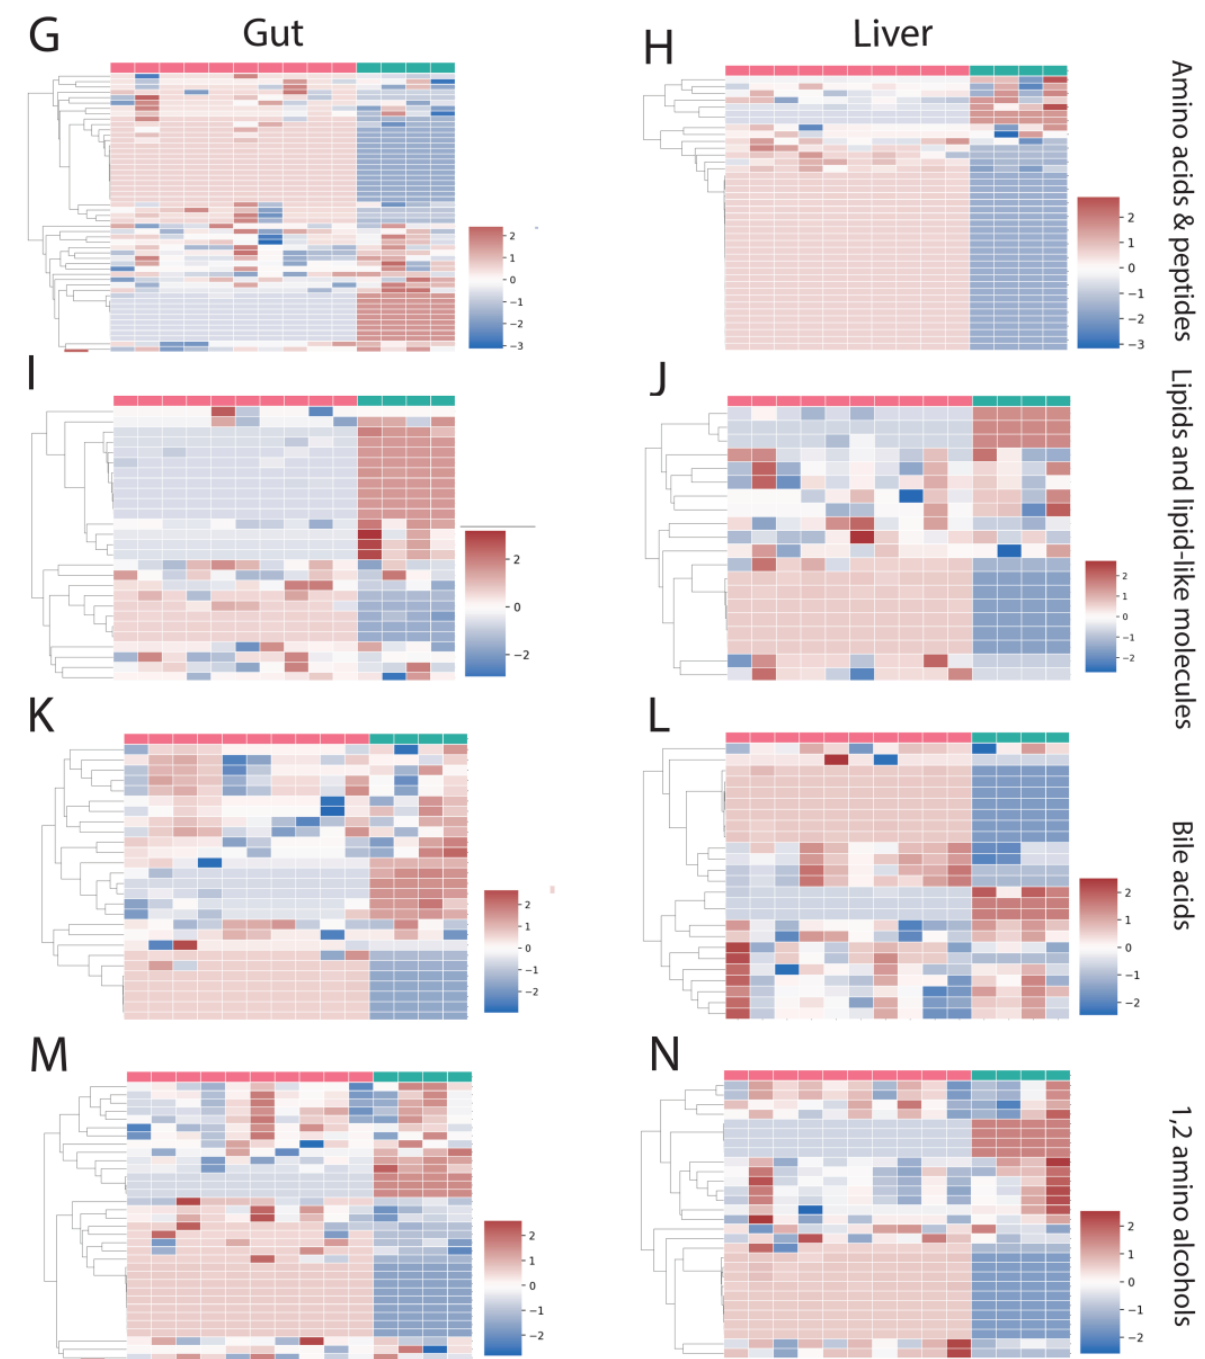
Figure 4. Perturbed chemical families in common between two organs. ( A – F ) Perturbed chemical families in common between liver and spleen (carbohydrates, glycerophosphoethanolamines, and fatty acids). ( G – N ) Perturbed chemical families in common between gut and liver (amino acids and peptides, lipid and lipid-like molecules, bile acids, 1,2-amino alcohols). Infected samples are shown in red and uninfected samples in green. Each column represents one sample, and each row represents one metabolite feature. Scale shows zero mean and unit variance (higher than zero mean = red and lower than zero mean = blue color) at each